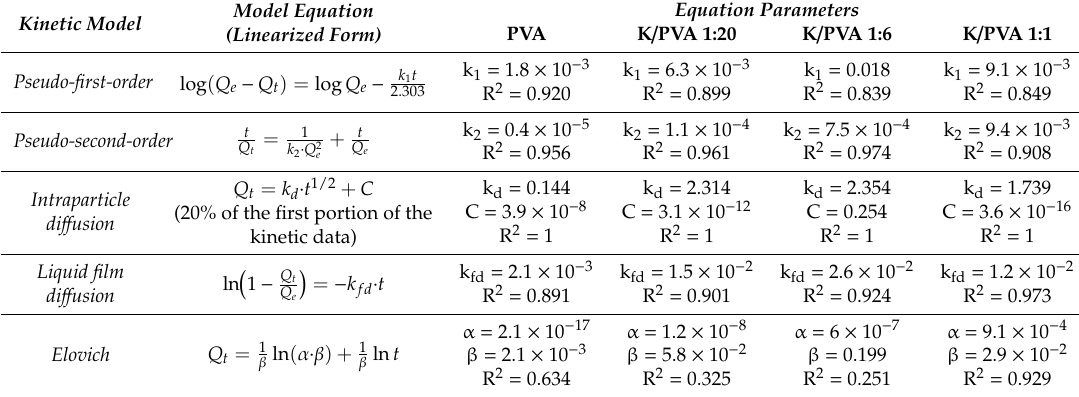
Table 6. Parameters of the isotherm models fitted onto the experimental CV adsorption data. Kinetic